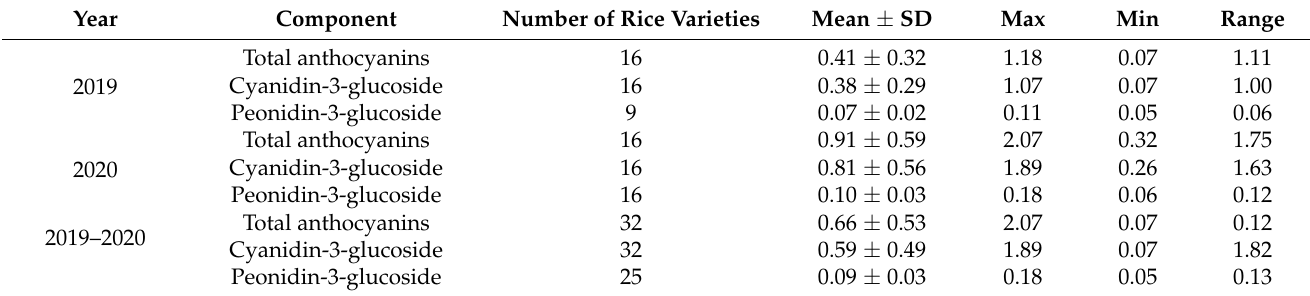
Table 2. The reference value of anthocyanins (mg/g) obtained through HPLC analysis.